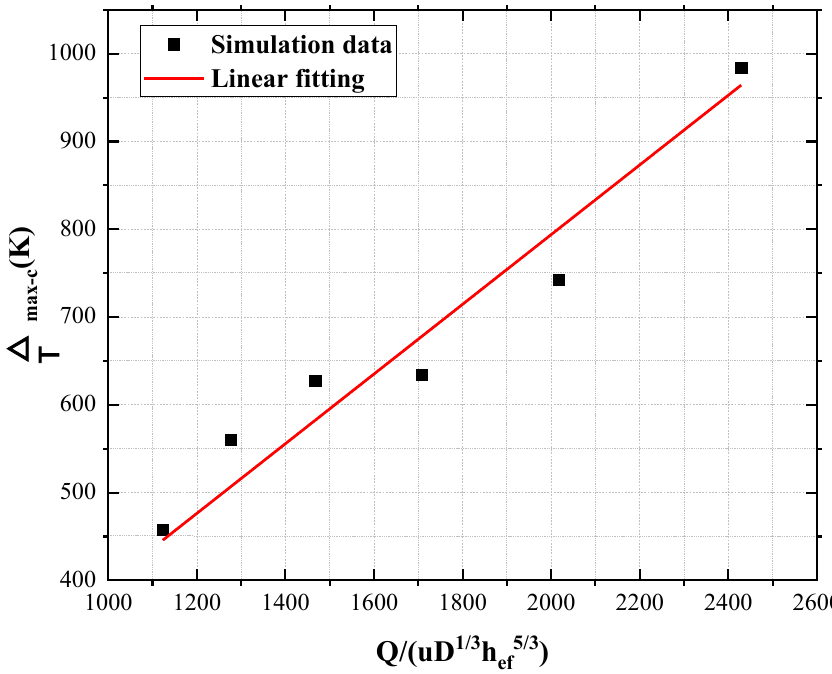
Figure 5. Fitting of Li’s formula and simulation data.